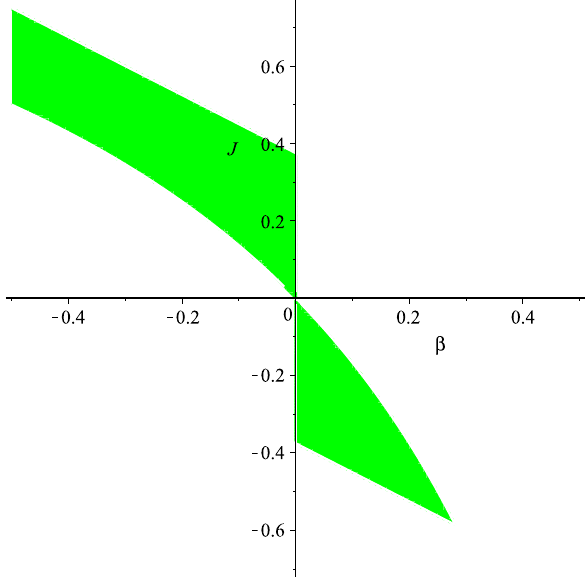
The condition | β | ≤ 1 / 2 is necessary to get | ζ 1 | < 1 during